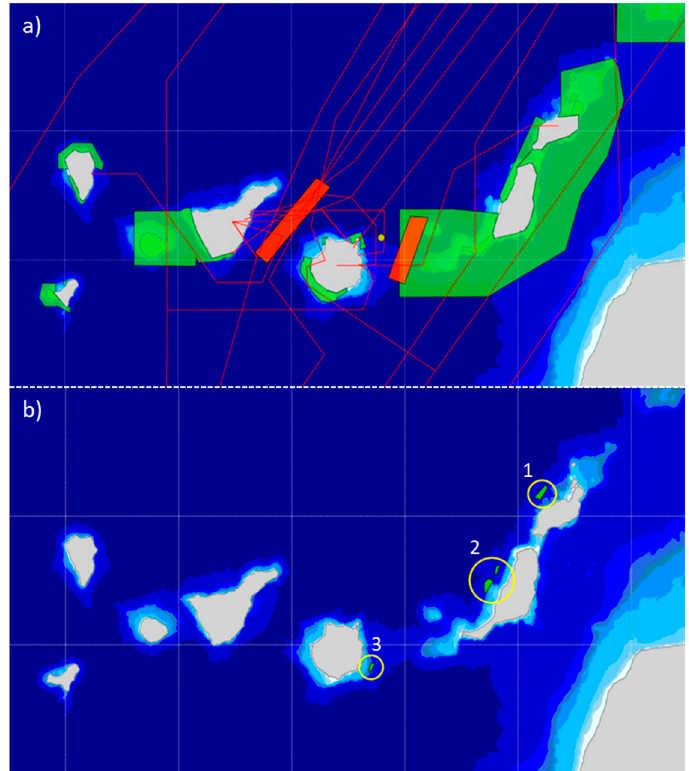
Figure 3. Some exclusion layers and the potential sites in the Canary Archipelago (latitude, longitude: 28.291565, -16.629129). ( a ) Protected areas (green), maritime route (orange), pilot zone (yellow) and underwater lines (red). ( b ) Proposed locations of Lanzarote (1), Fuerteventura 1&2 (2) and Gran Canaria (3).